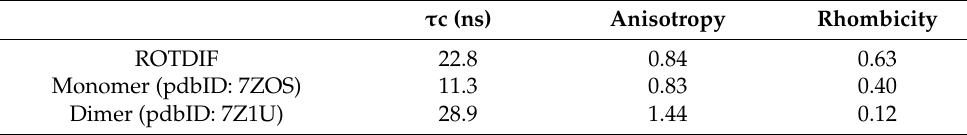
Table 2. Properties of diffusion tensor determined by ROTDIF and HYDRONMR. τ c